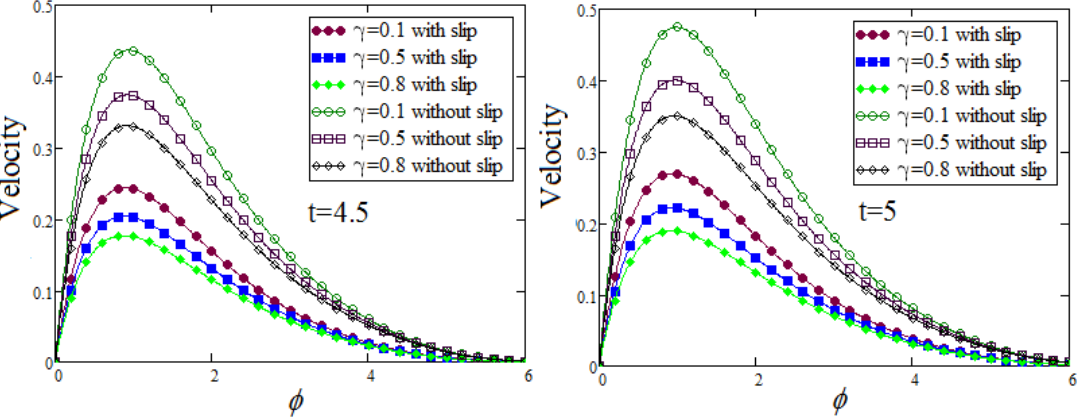
Figure 11. Graphical representations of velocity profile in the presence of slip and no slip conditions by taking the dissimilar values of β at two different levels of time, when Gr = 5, Gm = 3.5, ℘ = 0.4, Pr = 12, ω = 0.5, Sc = 9, γ = 0.3, and α = 0.5.